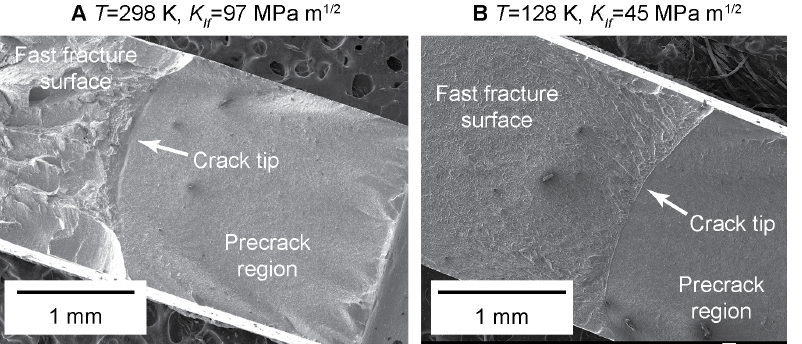
Figure 2. Fracture surfaces of SENB specimens of Zr 57 Ti 5 Cu 20 Ni 8 Al 10 tested at (a) 298 K and (b) 128 K. The fatigue pre-cracking process produces a relatively flat fracture surface with a curved crack tip. When the specimen fails at the critical load, a fast-fracture surface morphology results that is much rougher for the specimen tested at room temperature than for the cryogenic specimen.